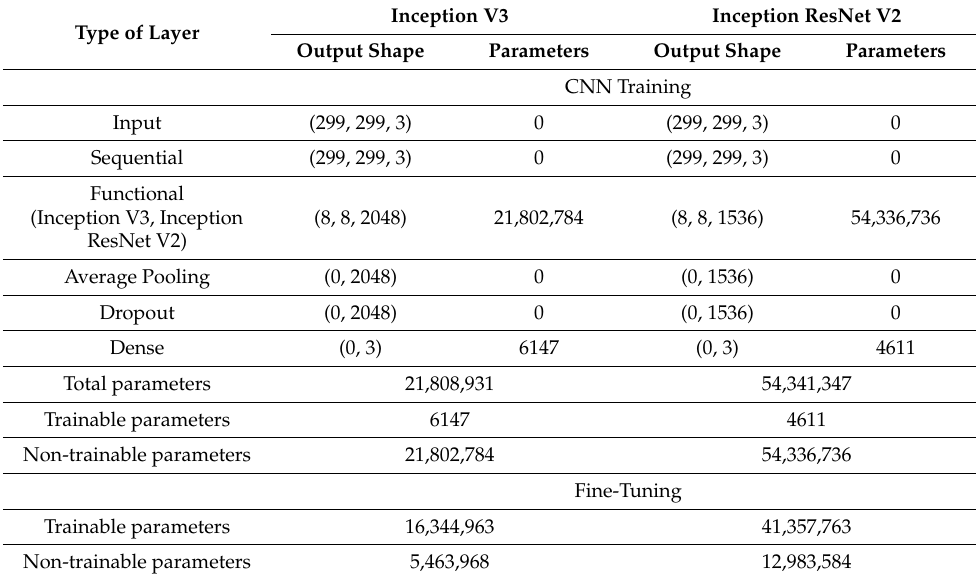
Table 4. Summary of tomato disease diagnoses